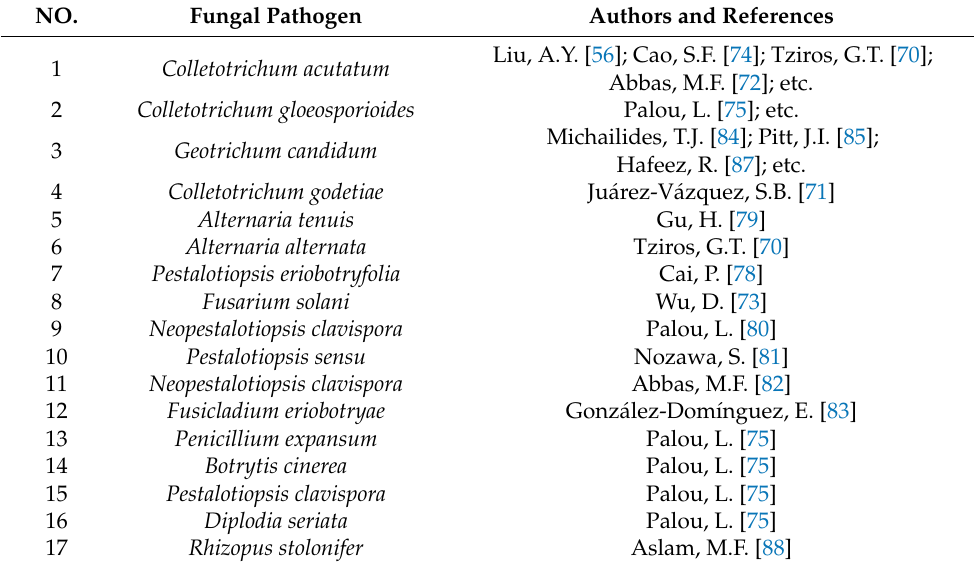
Table 1. List of fungi that cause postharvest decay of loquat fruit.